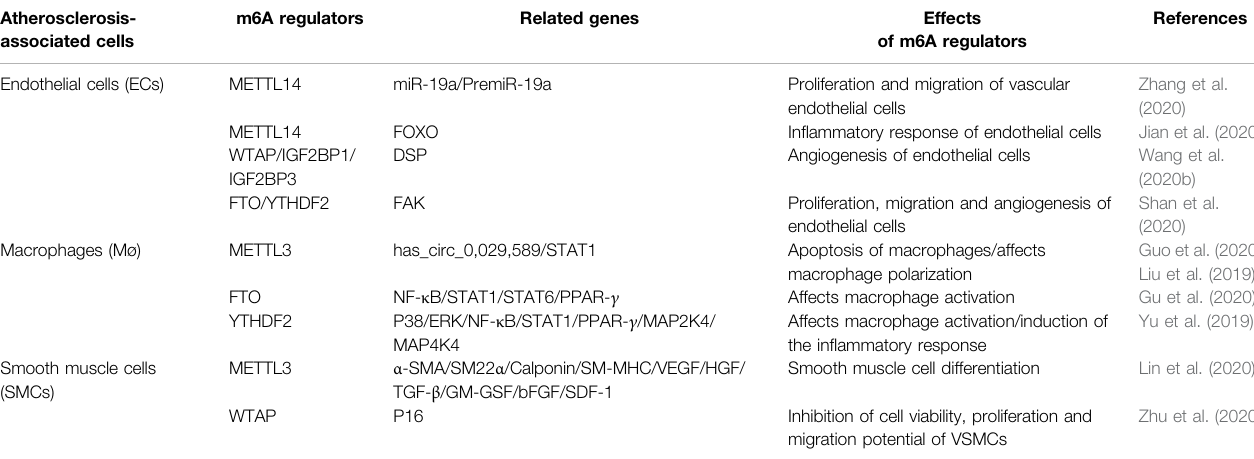
TABLE 1 | Regulation of m6A methylation-related enzymes in cells involved in